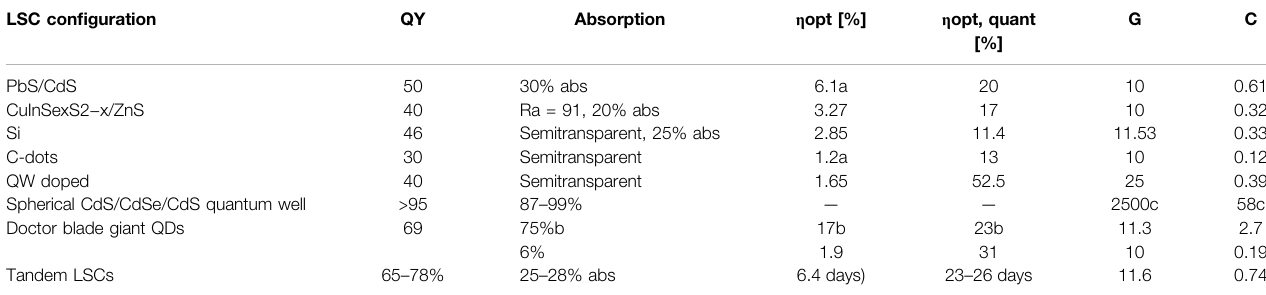
TABLE 4 | Properties of different LSC con fi gurations (Mazzaro and Vomiero, 2018). Con fi guration — outer section of the greenhouse is covered by PV cells while the others are fi tted with re fl ective mirrors. G calculated at a single wavelength; micro-PV cell embedded measured resonant optical cavity con fi guration. LSC con fi guration QY Absorption